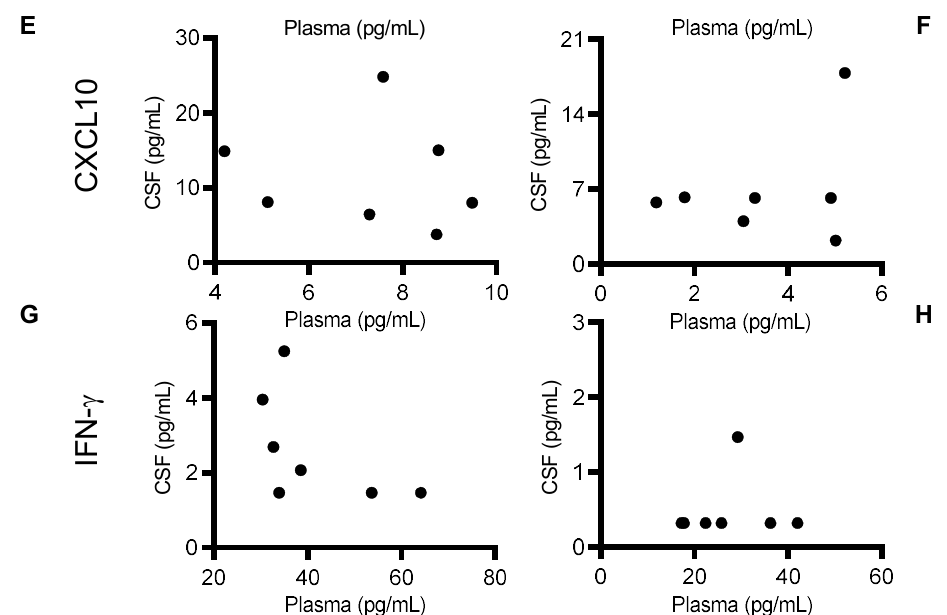
Figure 3. Association of levels of cytokine and chemokine between the CSF and plasma of SIV-infected chRMs with ART ( right panels) or without ART ( left panels). ( A , B ), ( C , D ), ( E , F ) and ( G , H ) show CCL2, IL-6, CXCL10, and IFN-γ levels respectively.